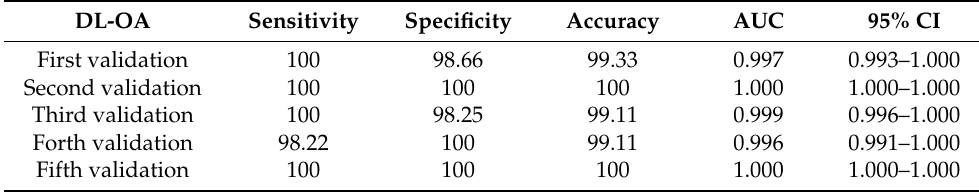
Table 2. Results summary of five-fold, cross-validation of DL-OA model for detecting over-scanning at the lung apex (CI, confidence